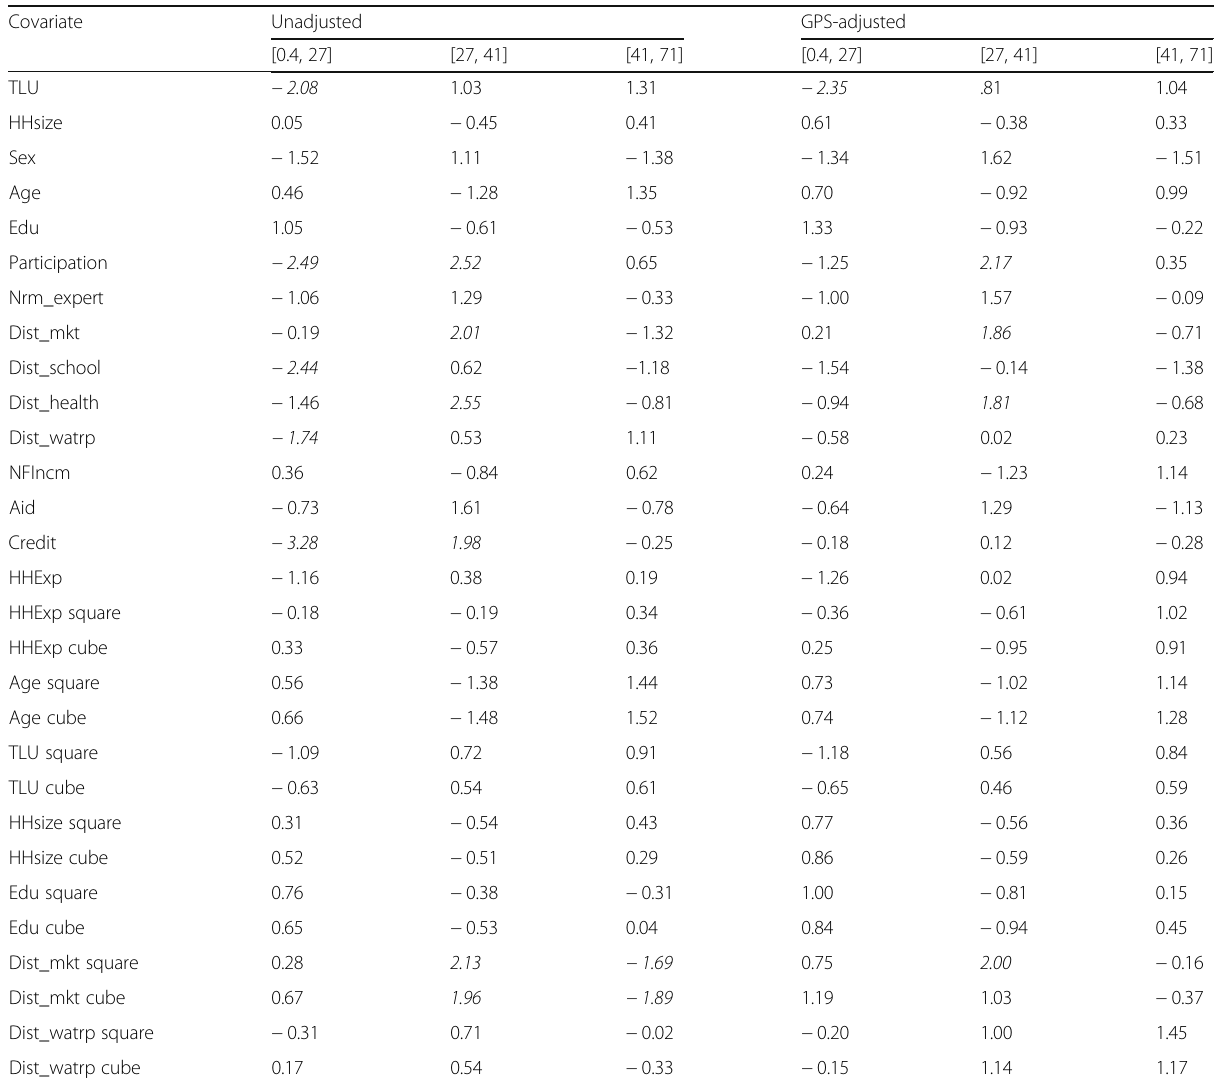
Table 6 Balance of covariate accounting for the GPS: t -statistics for equality of means Covariate Unadjusted GPS-adjusted